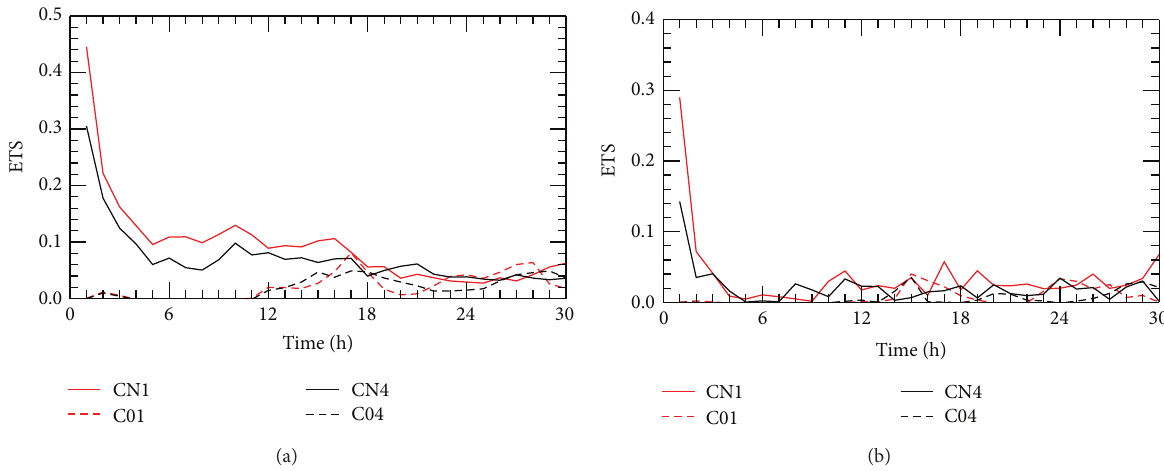
Figure 4: Equitable threat scores (ETSs) of hourly accumulated precipitation at 0.1 inch (a) and 0.5 inch (b) thresholds, for the 1km forecast with radar data (CN1, solid red), 1km forecast without radar data (C01, dashed red), 4km control (CN4, solid black), and 4km run without radar data (C04, dashed black), for the 26 May 2008 case, for hour 1 through